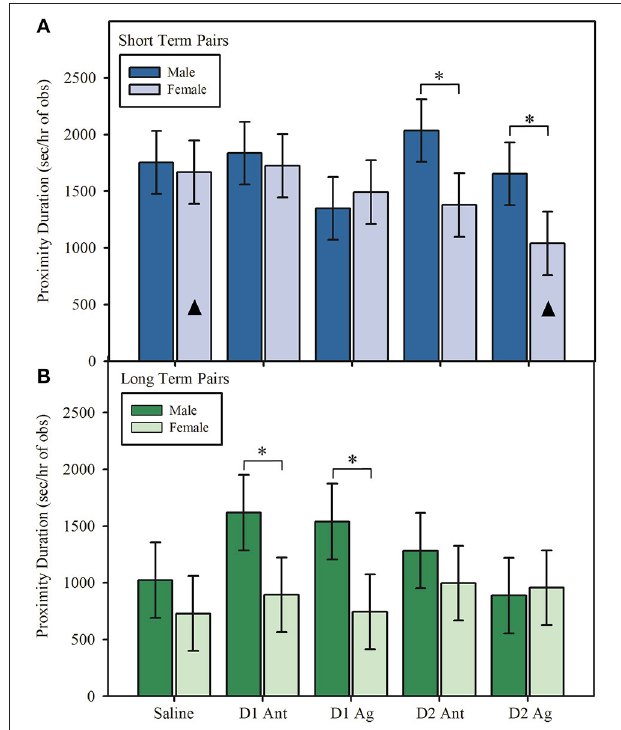
FIGURE 3 | Grooming (model estimates ± SEM) among short and long term marmoset pairs. (A) There was no difference in time spent grooming during reunion between short and long term pairs of marmoset monkeys. (B) Treated marmosets in short term pairs initiated grooming more often than they received grooming, regardless of treatment, whereas treated marmosets in long term pairs initiated grooming equally as often as they received grooming. *Indicates significant difference at p < 0.05.